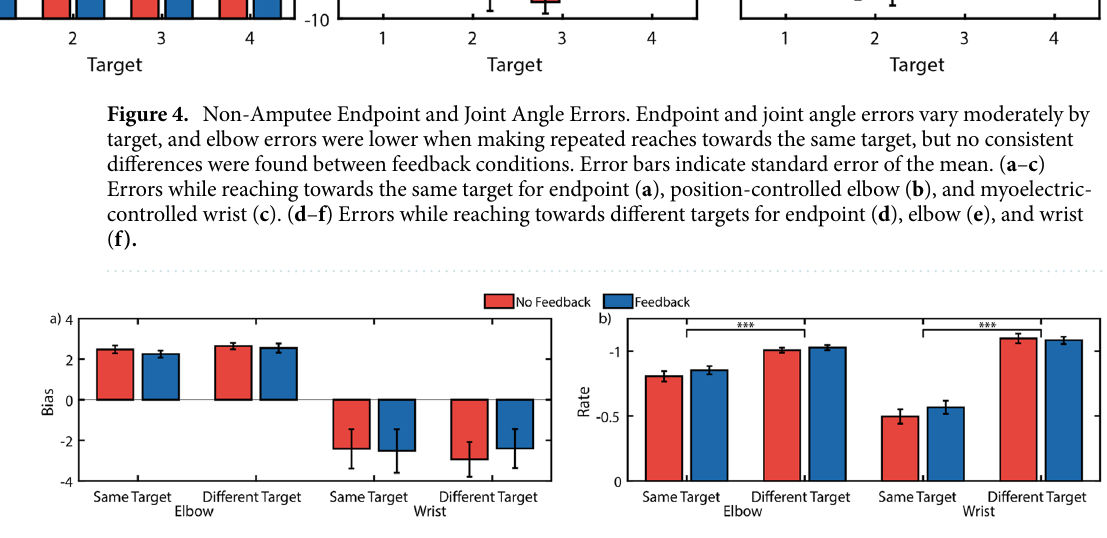
Figure 5. Non-amputee trial-by-trial adaptation analysis. Trial-by-trial adaptation biases suggests the elbow overreaches to compensate for an underreaching wrist as shown by the opposite signs of elbow and wrist biases. However, no changes in trial-by-trial adaptation behavior was observed between feedback conditions. ( a ) Trial- by-trial adaptation bias ( b ) Trial-by-trial adaptation rate. ***Indicates p <